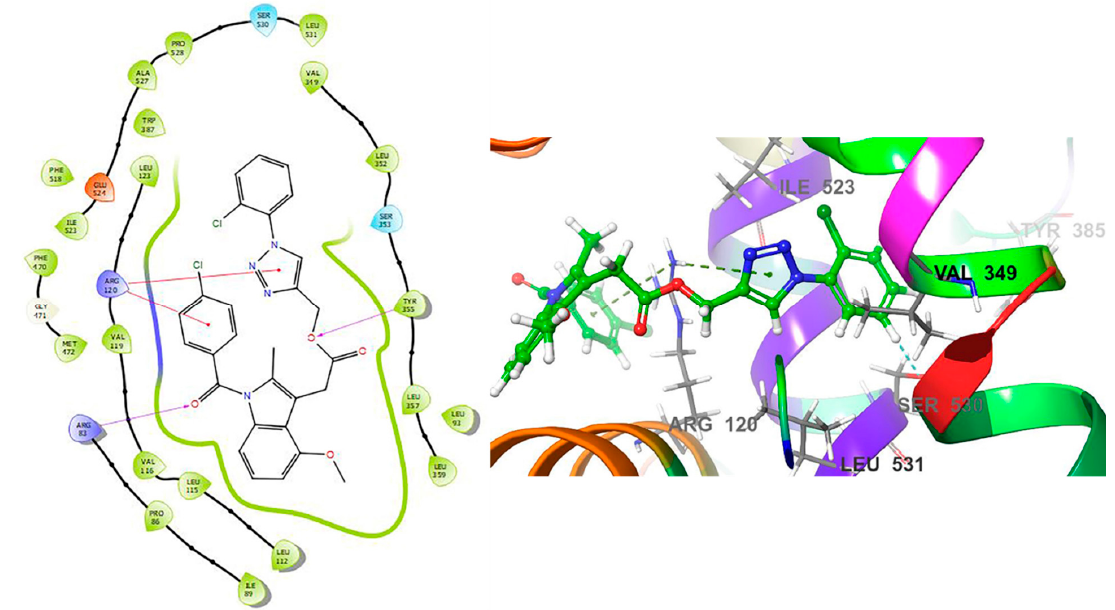
Figure 7. Binding interactions and docked pose of compound 5a in the COX-1 crystal structure, PDB: 3N8W. There is a loss of interactions with Leu531 and Val349, whereas interaction with Ser530 is observed. The choro group is oriented on the other side of the binding pocket and interacts with Ile523.